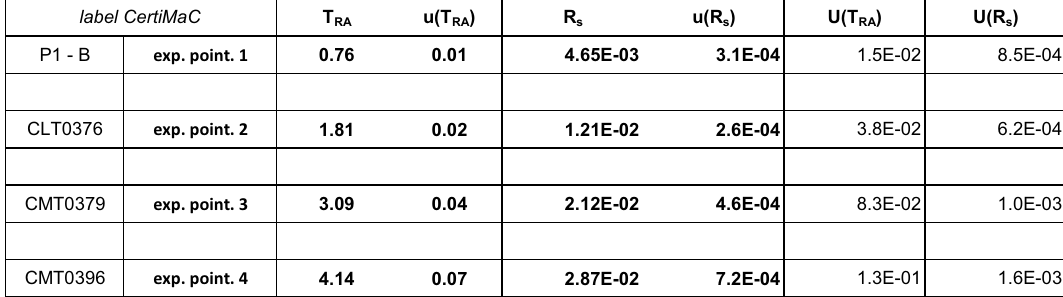
Table 3. Synthesis of thermal resistances, and associated uncertainties, determined for different materials by using the regression parameters estimated by